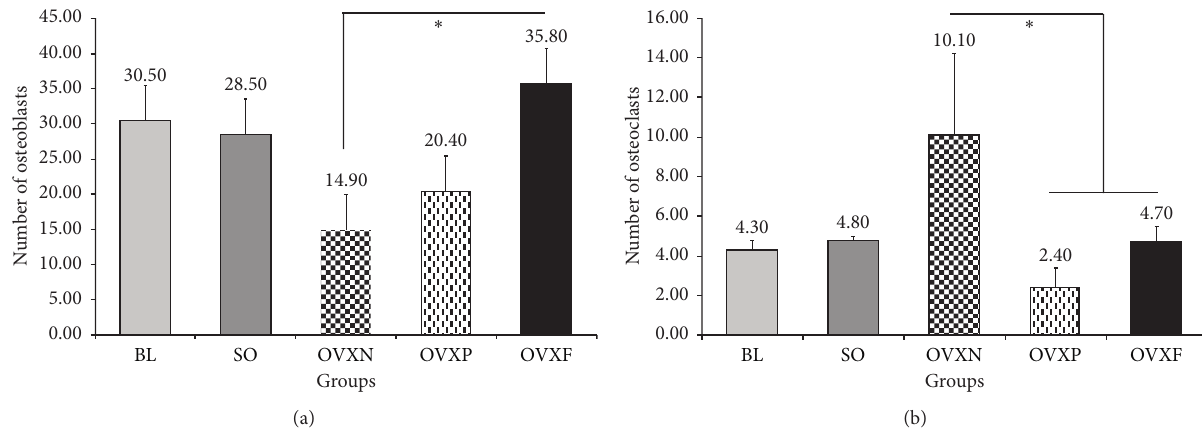
Figure 10: The mean values and standard deviation of the number of osteoclasts and osteoblasts in all the groups. ∗ A significant difference at p < 0 .